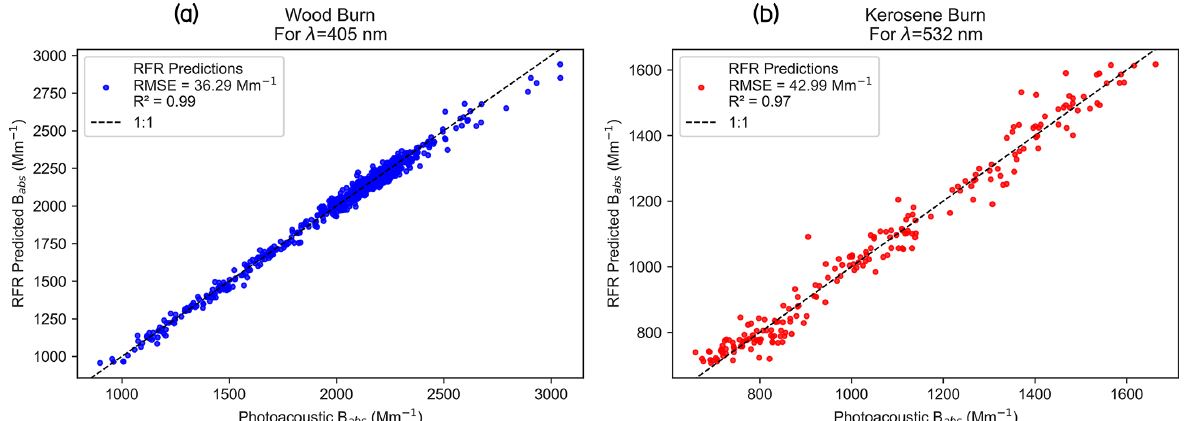
Figure 8. An illustration of the power of the RFR algorithm in accurately predicting the particle-phase absorption coefficient when trained with a robust set of input variables. The plots show the accuracy of RFR-trained TAP absorption coefficients in comparison to the reference PASS absorption coefficients corresponding to (a) 405nm and (b) 532nm for laboratory-generated aerosols from